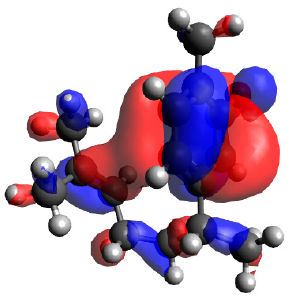
Figure 5. Molecular orbital lobe diagram of the xanthorrhizol ( 1 ) radical cation (next highest occupied molecular